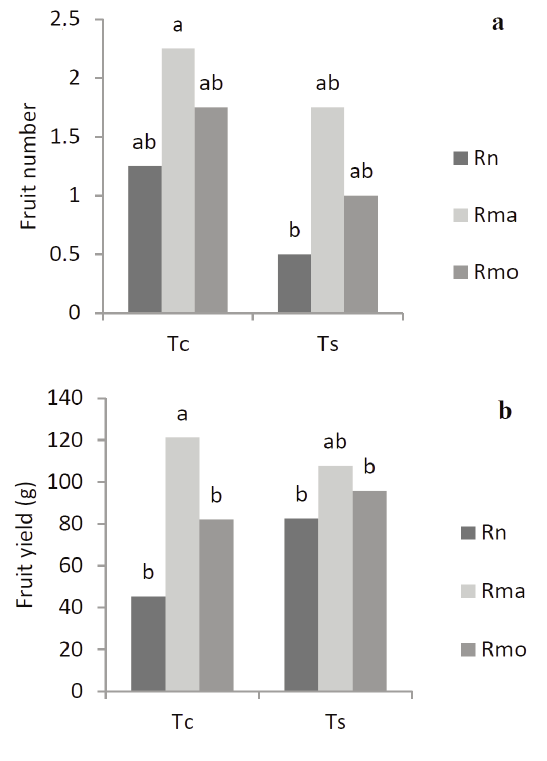
Fig. 4 ­ The interaction effect of temperature and cucumber grafting on fruit number (a) and fruit yield (b) Momordica charantia Rs did not have fruit. Tc= optimum temperatu­ re; Ts= low temperature; Rn = nongrafted ( Cucumis sati‐ vus var. DavosII); Rs= self grafted; Rma= Cucurbita maxi‐ ma ; Rmo= Momordica charantia.